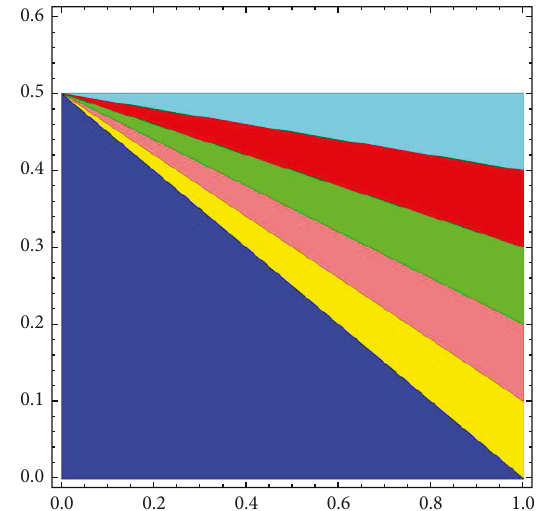
Figure 3: Region of 𝑥𝑦 plane where (40) holds true for 𝜃 = 0, 0.2, 0.4, 0.4, 0.6, 0.8, 1 represented by cyan, red, green, pink, yel- low, and blue colors, respectively.